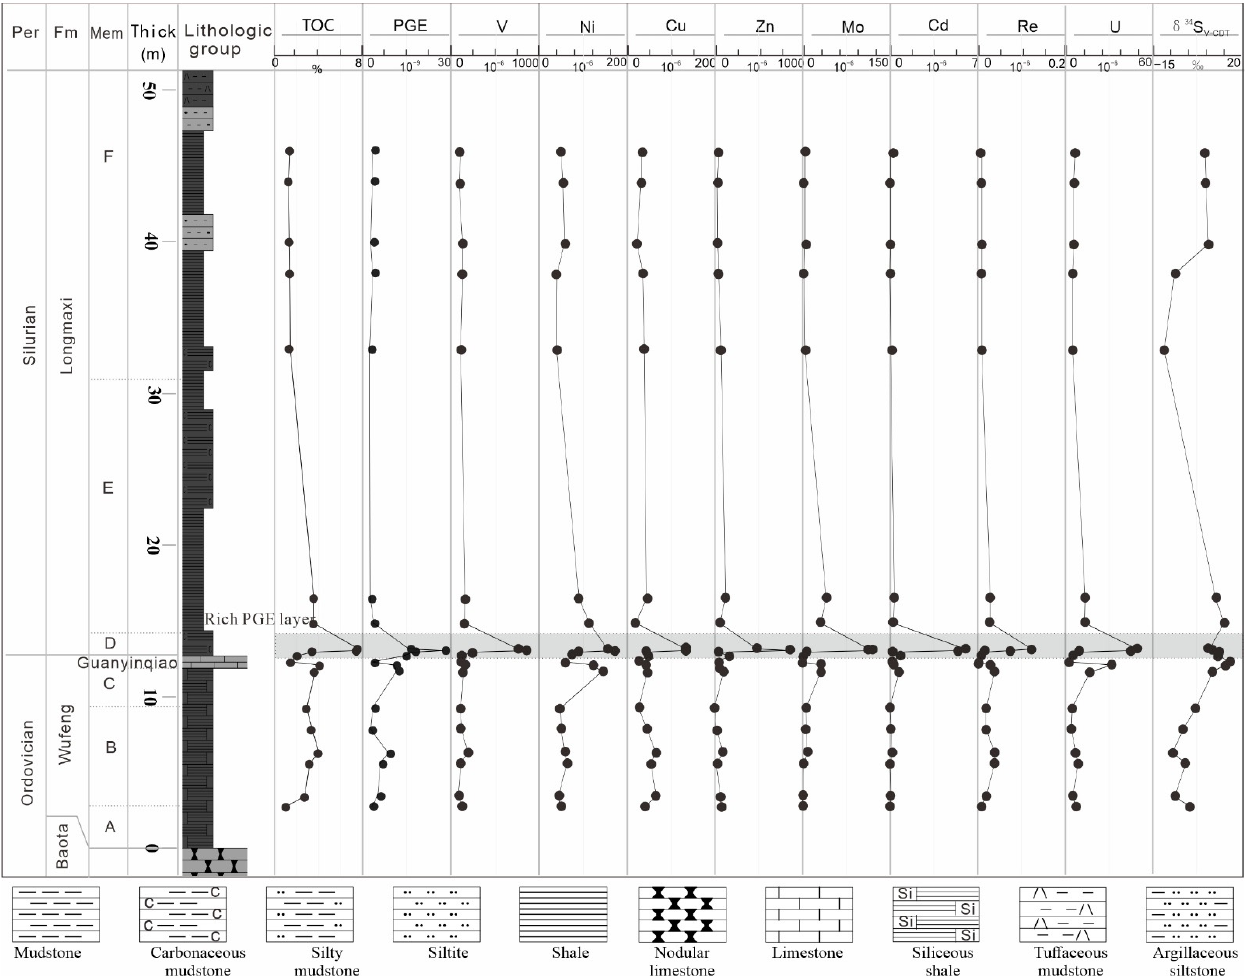
Figure 4. Trace element characteristics in CN outcrop. Table 2. Trace elements and REE and relevant parameters of CN outcrop. The rare earth elements (REE) of CN outcrop are shown in Table 2. The ∑ REE values are 81.77 × 10 − 6 ~281.70 × 10 − 6 , with the average of 142.73 × 10 − 6 . This value is close to the average of UCC (146.4 × 10 − 6 ) and slightly lower than that of the PAAS (183.03 × 10 − 6 ) [23]. The total amount of light rare earth elements ( ∑ LREE) ranges from 72.86 × 10 − 6 to 260.5 × 10 − 6 , with an average of 128.54 × 10 − 6 , accounting for 90% of the ∑ REE. The